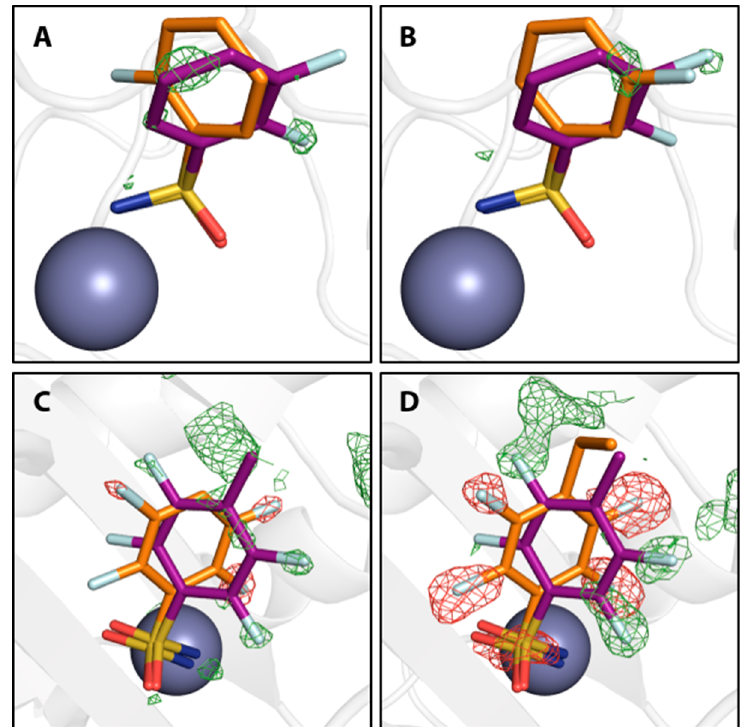
Figure 4. Compounds 3 , 4 , 9 , and 12 in orange with putative additional binding conformations. Positive and negative mFo-DFc maps are shown in green and red at 3 σ and -3 σ , respectively. Compounds 3 ( A ) and 4 ( B ) are shown in comparison with compound 6 in purple to indicate the second conformation. Compounds 9 ( C ) and 12 ( D ) are shown in comparison with compound 11 in purple to indicate the second conformation. The Zn II cofactor is shown as a gray sphere.